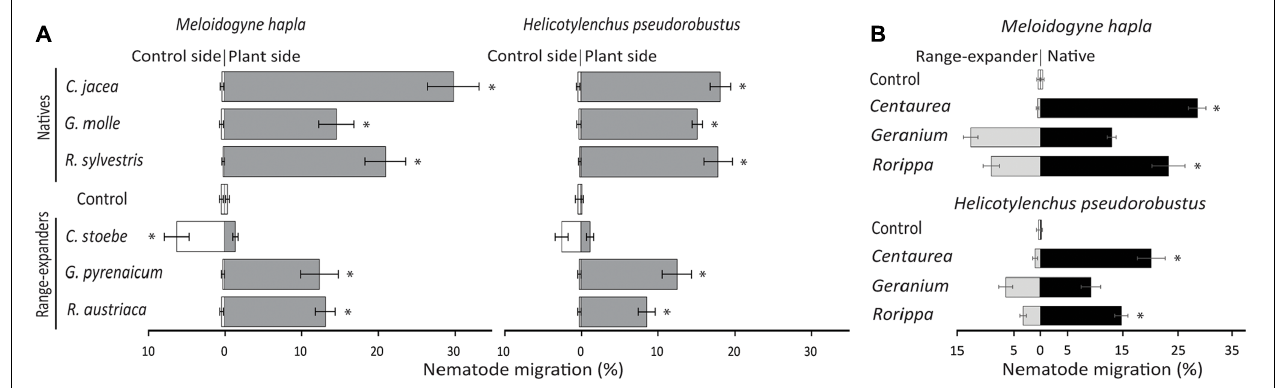
FIGURE 1 | (A) Attraction or repellence (% individuals migrated) of the nematode species Meloidogyne hapla and Helicotylenchus pseudorobustus by native and range-expanding plant species in sterilized soil. (B) Nematode preference between native plant species Centaurea jacea , Geranium molle, and Rorippa sylvestris and congeneric range-expanders C. stoebe , G. pyrenaicum, and R. austriaca . In both panels horizontal bars show averages ± standard errors and asterisks represent significant paired t -test values ( p < 0.05) between empty control and plant (A) or between native and range-expanding plant species (B)